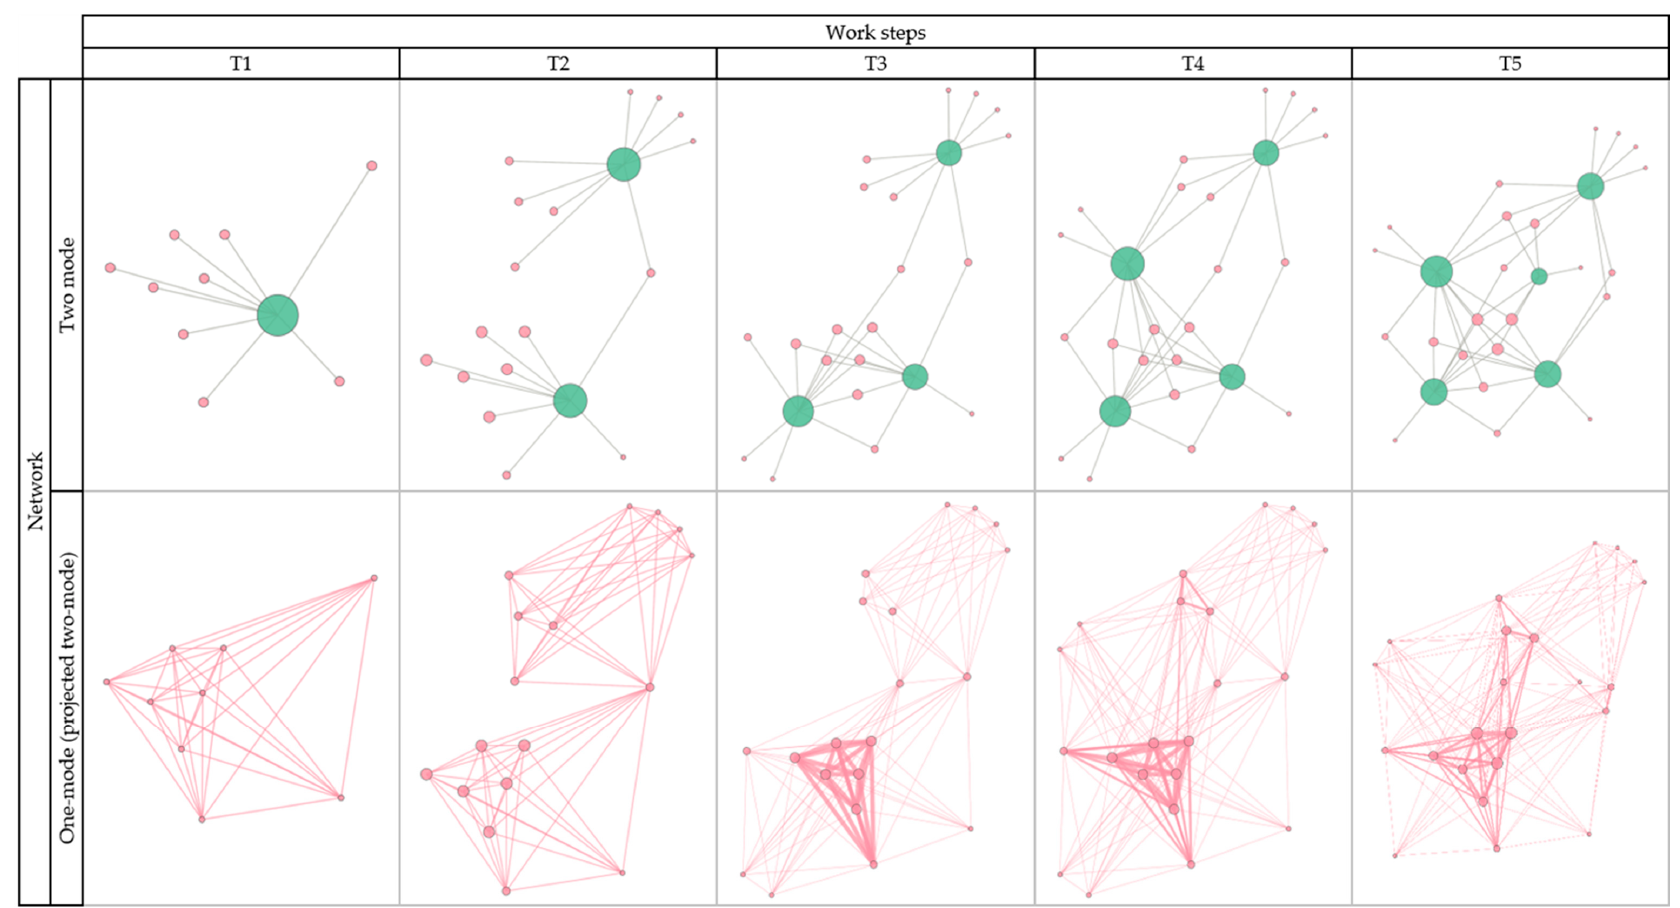
Figure 1. Visualization of the network at the five work steps: T1 (letter of intent), T2 (on-site information and consultation), T3 (stakeholder workshop), T4 (stakeholder workshop II), and T5 (steering group (digital meeting)) (red = organizations; green = events); top row: two-mode network; bottom row: one-mode (projected two-mode) network.